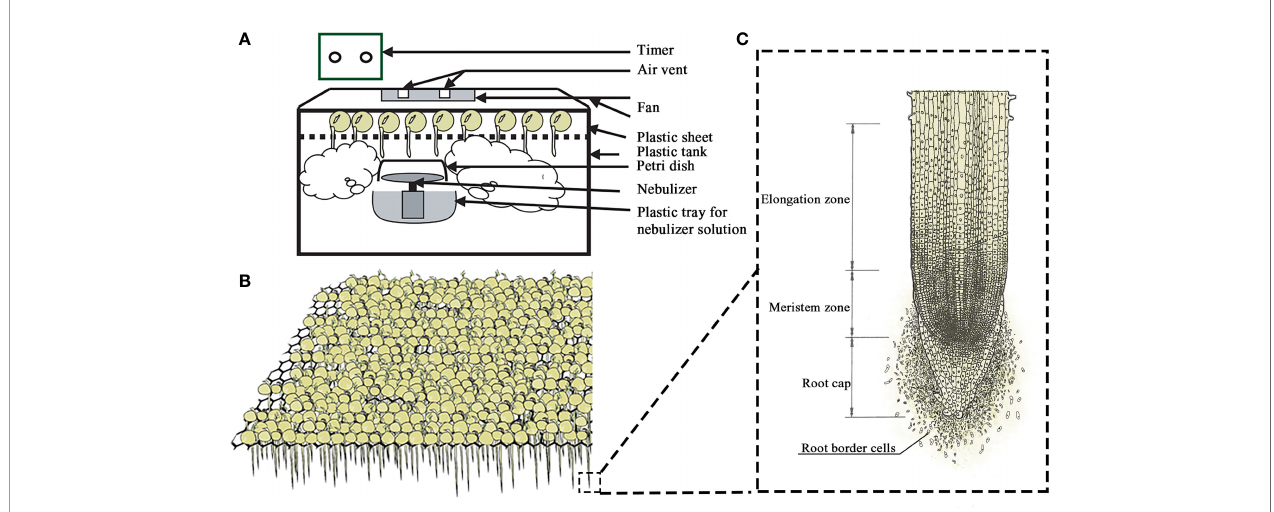
FIGURE 3 | Scheme of the mist-culture device (A) for easy mass production and harvesting of pea seeds (B) and root border cells (C) with their root tips exposed to the humid